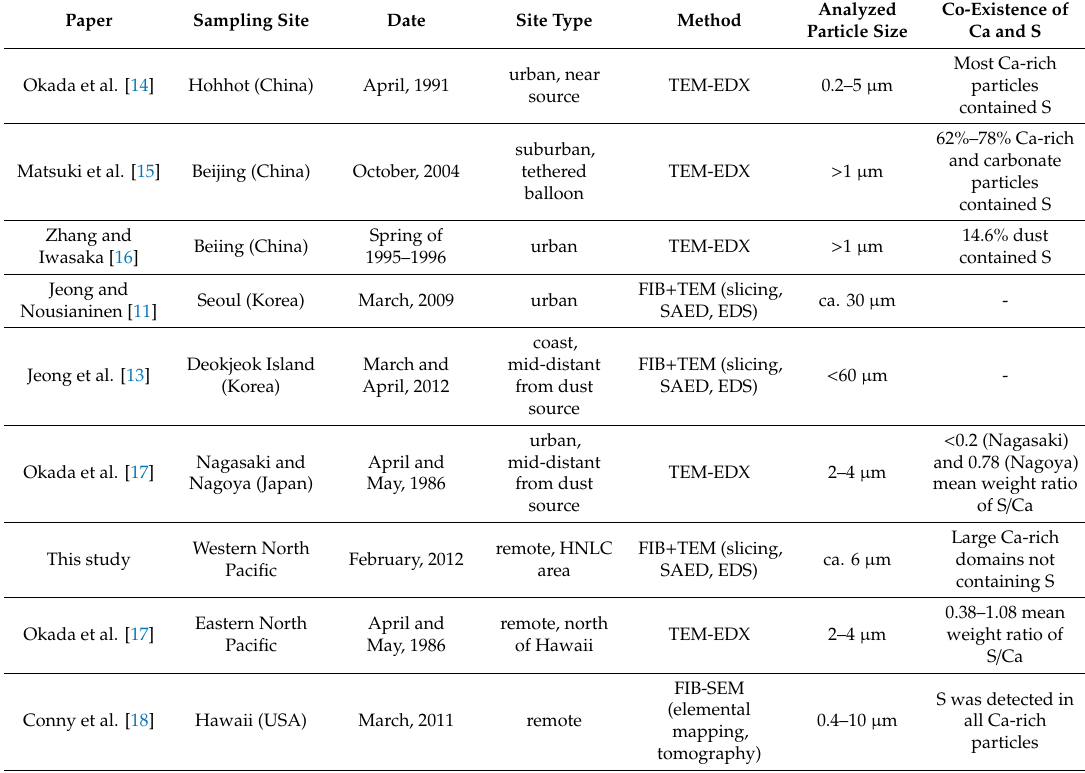
Table 1. Studies of individual, Ca-rich Asian dust particles by using electron